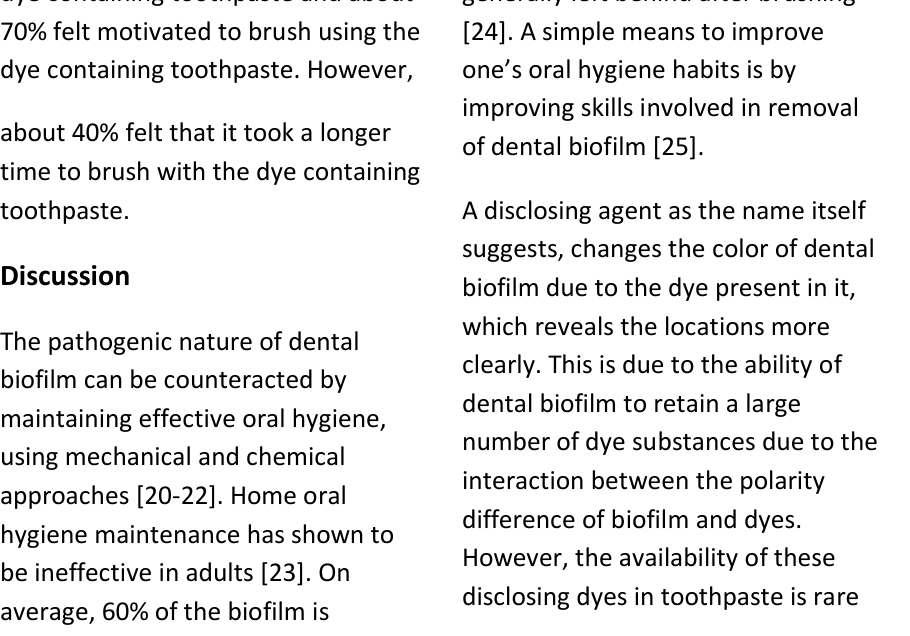
Table 3: Experimental group’s feedback on dye containing toothpaste